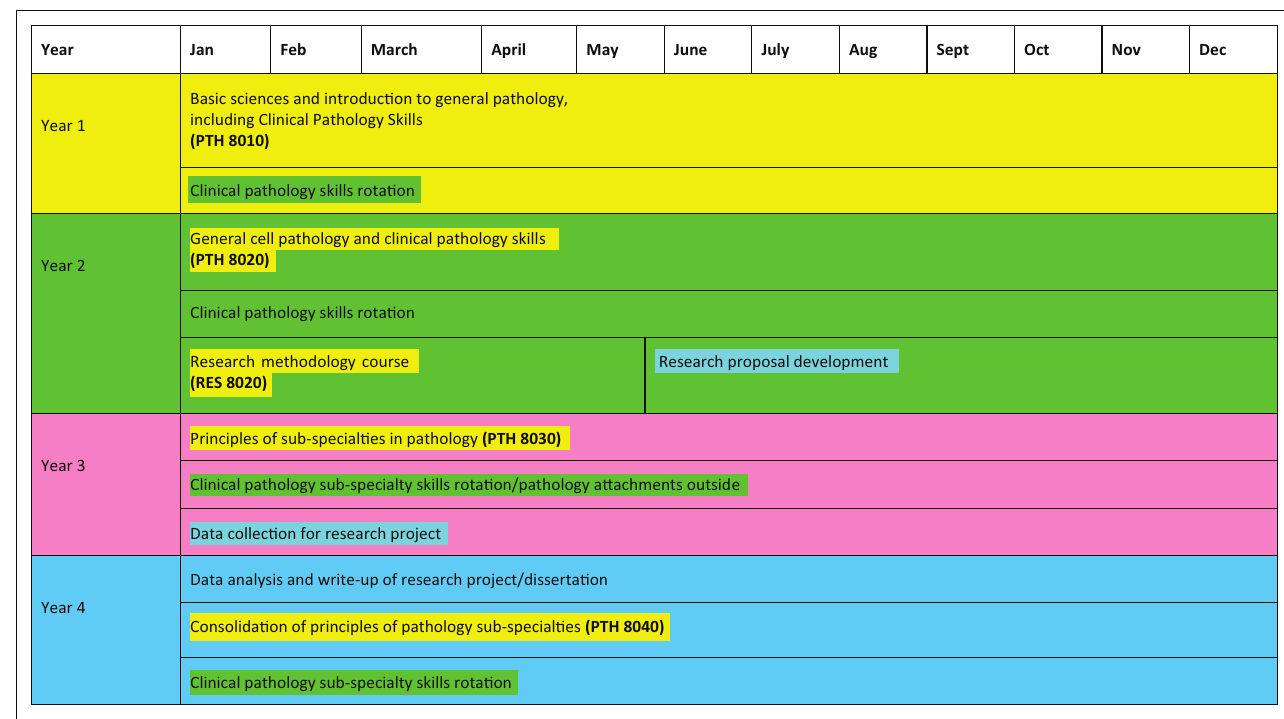
FIGURE 1: Programme map for development of MMed programme, Zambia,